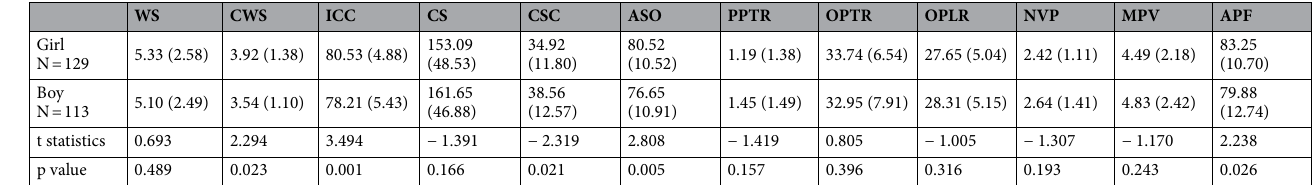
Table 6. The comparison of testing measures between genders. WS Writing speed, CWS Correct writing speed, ICC Intra-character configuration, CS Character size, CSC Character size consistency, ASO Accuracy of stroke order, PPTR Pen pause time ratio, OPTR On-paper time ratio, OPLR On-paper length ratio, NVP Number of velocity peak per stroke, MPV Mean peak velocity, APF Axial pen